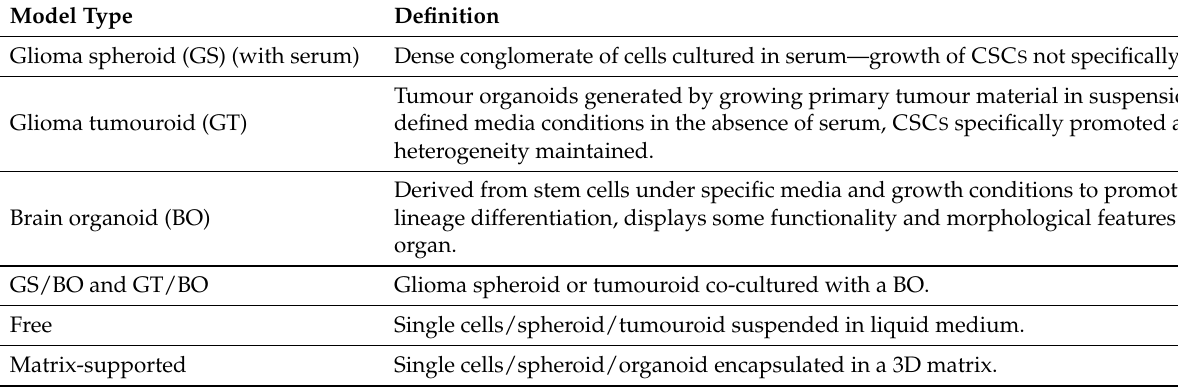
Table 2. Definitions of the different types of GBM/brain models used throughout this review to compare and contrast existing literature. All models can be matrix-supported or free. Model